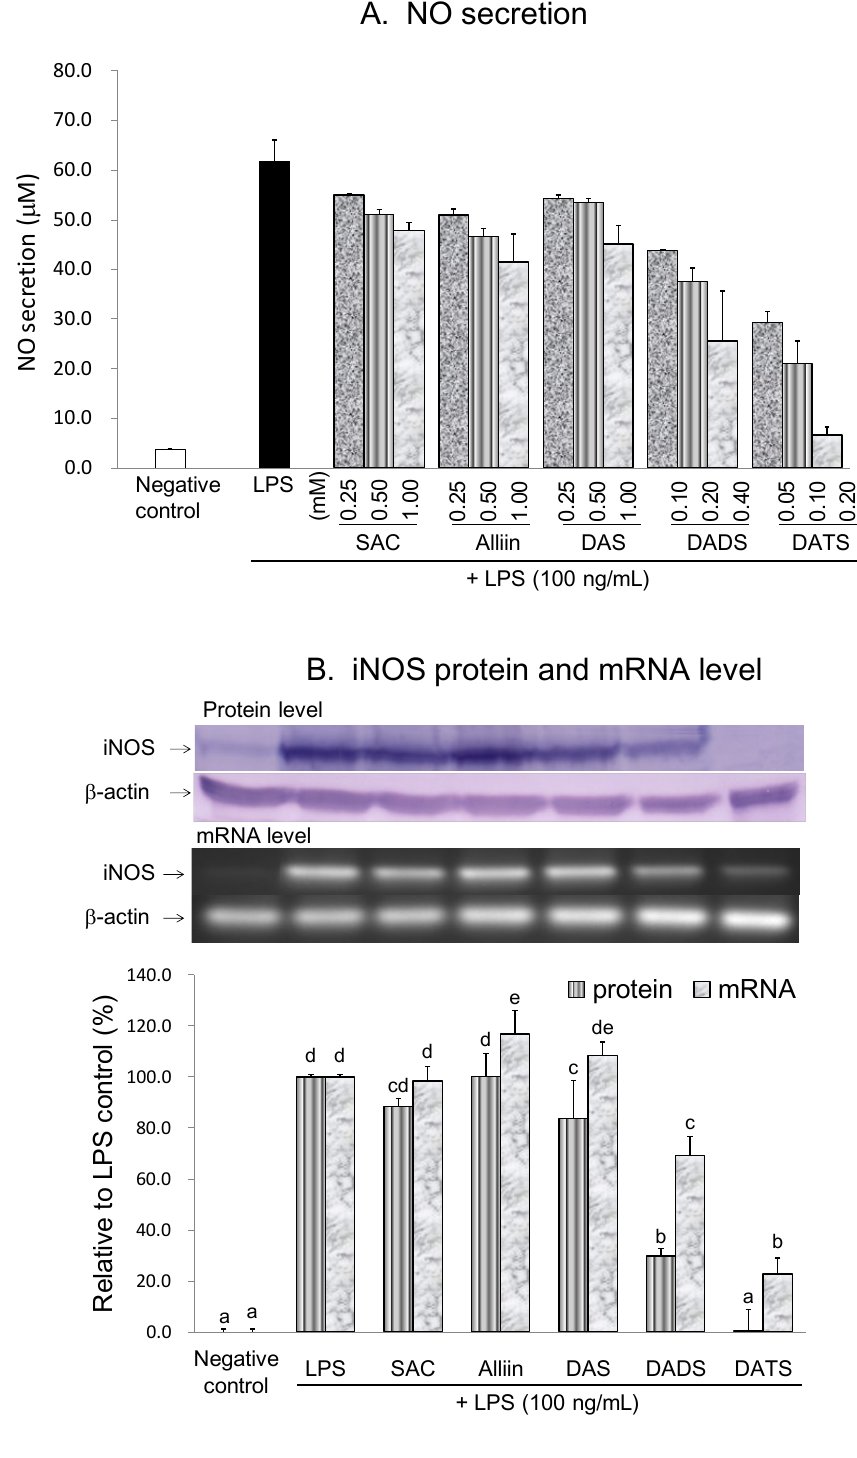
Figure 4. Effects of the selected OSCs on the NO production ( A ); iNOS protein and mRNA levels ( B ) in LPS-activated BV2 microglia. In part B, the treatment concentration is 1000 µM for SAC, alliin and DAS; 400 µM for DADS; and 200 µM for DATS. The values are expressed as means ± SD of triplicate tests. Means not sharing a common letter were significantly different ( p < 0.05) when analyzed by ANOVA and Duncan’s multiple range